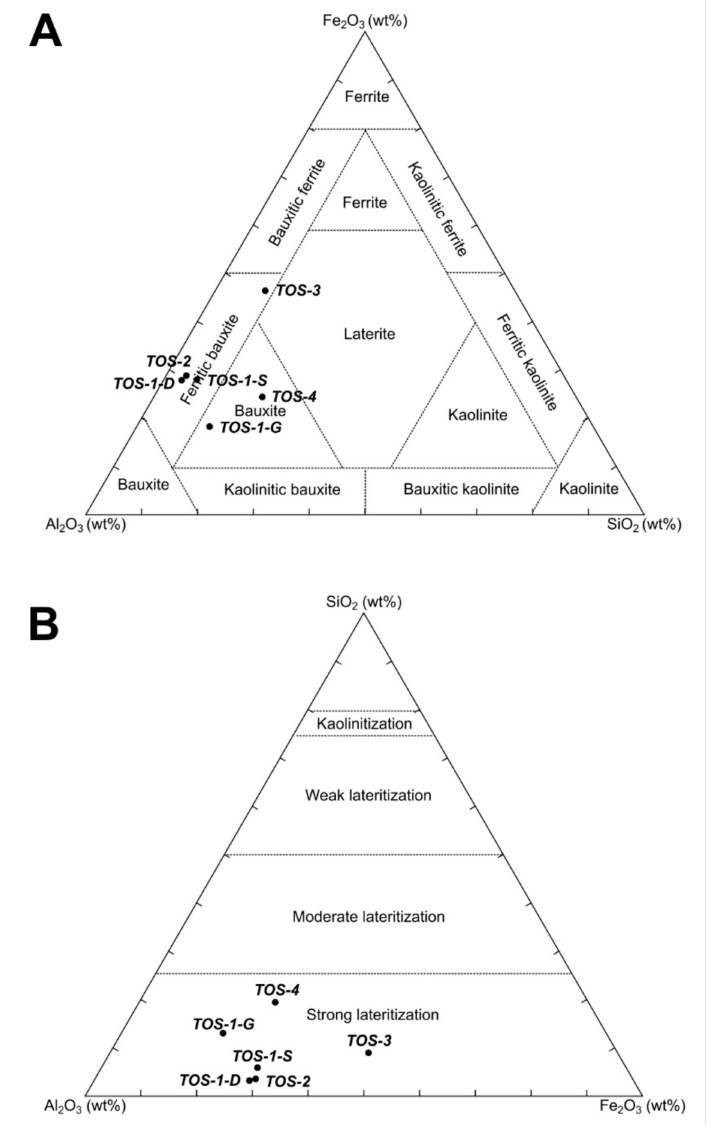
Figure 6. Ternary diagrams: ( A )—SiO 2 -Al 2 O 3 -Fe 2 O 3 after [30] presenting mineralogical classifica- tion of bauxite in the Toši´ci-Duji´ci deposit; ( B )—Al 2 O 3 -SiO 2 -Fe 2 O 3 after [31] showing degree of lateritization in the Toši´ci-Duji´ci